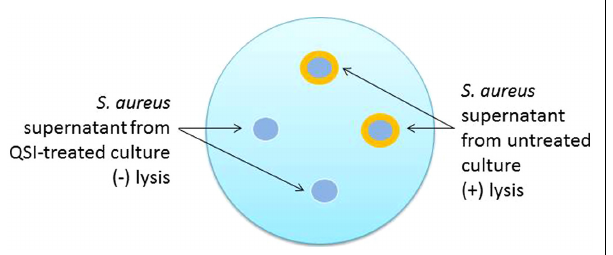
FIGURE 2 | Schematic representation of the phospholipase plate assay for the identification of quorum sensing inhibitor (QSI) activity. In this test, 18 h cultures are grown either in the presence or absence of QSI, the supernatants harvested and sterile filtered, and then added to the punch holes made in the phospholipid plate. Following an additional 18 h incubation period, the plates are exposed to UV irradiation and photographed.The orange halos indicate the lytic activity of untreated supernatants. Supernatants from QSI-treated cultures would exhibit limited to no lytic effects and no orange